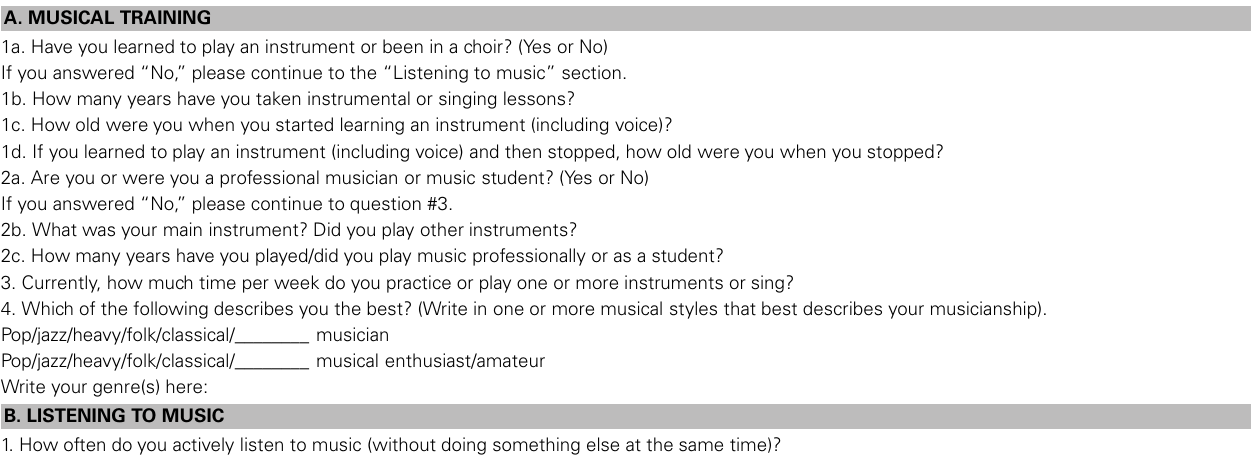
Table A2 | Helsinki inventory of music and affective